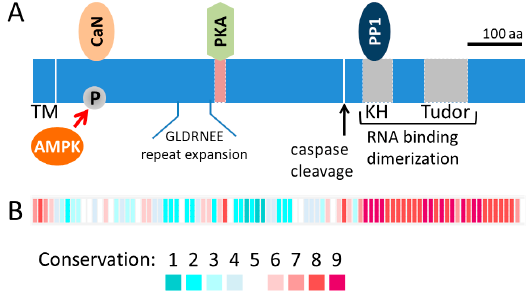
Figure 1. AKAP1 protein domain structure and sequence conservation. ( A ) Protein domain schematic of AKAP1 with the N-terminal OMM transmembrane at the left and the KH and Tudor domains at the C-terminus on the right. Included are some of the interacting proteins, CaN, PKA and PP1, and sites of post-translational modification by AMPK and caspases. The GLDRNEE repeat is expanded in many mammals, including humans, and it accounts for some of the variation in molecular weights across species. ( B ) Blocks represent the average conservation score of 10 residues and correspond to the diagram in (A). Block conservation was determined from the alignment of 113 orthologs using the ConSurf web server (http://consurf.tau.ac.il/). Abbreviations: AMPK, 5’ adenosine monophosphate-activated protein kinase; CaN, calcineurin; KH, K homology; PKA, protein kinase A; PP1, protein phosphatase 1; TM, transmembrane .